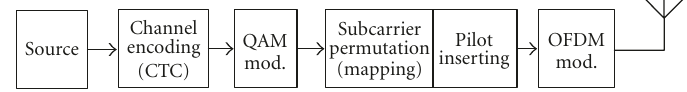
Figure 2: Transmitter architecture of one PSS.